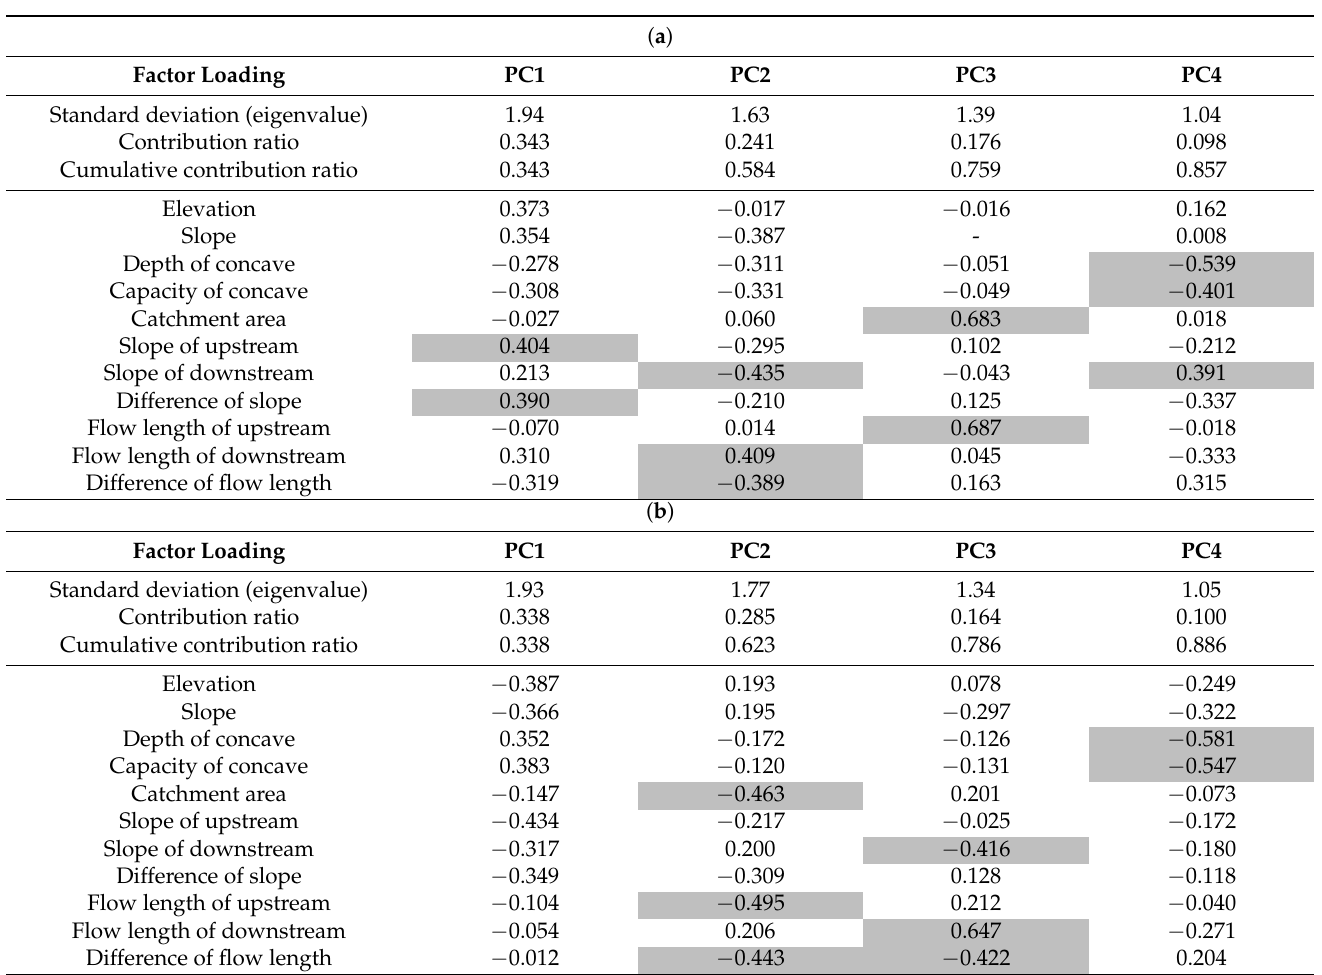
Table 5. ( a ) The PCA result for Osaka City. The shaded values are the factors that correlated the most in each PC. “-” indicates that no topographical factors in the principal components satisfied the 95% confidence interval. ( b ) The PCA result for Nagoya City. The shaded values are the factors that correlated the most in each